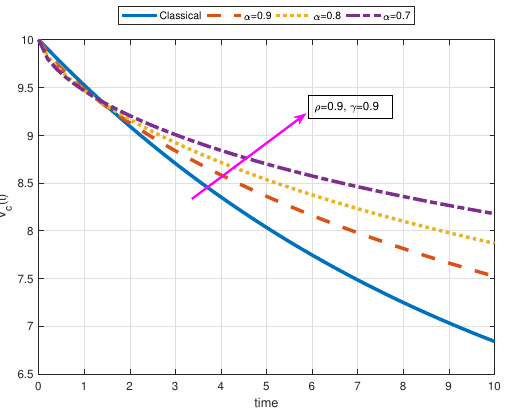
Figure 1. This figure corresponds to the function V c ( t ) with constant source for different values of α , ρ , and γ in order to show the effect of α on solution curves when R = 1 Ω , C = 10 F, e 0 = 5 V, and V c ( 0 ) =